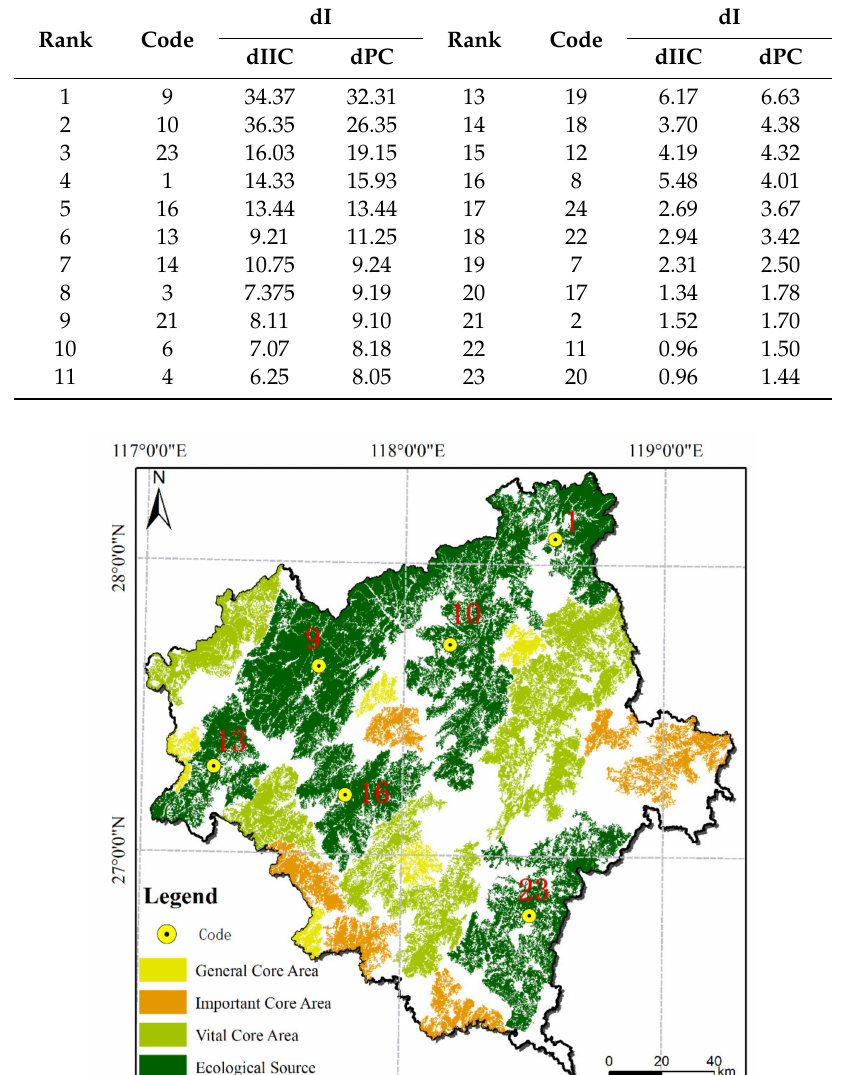
Table 3. Evaluation of the landscape connectivity index of the core areas.